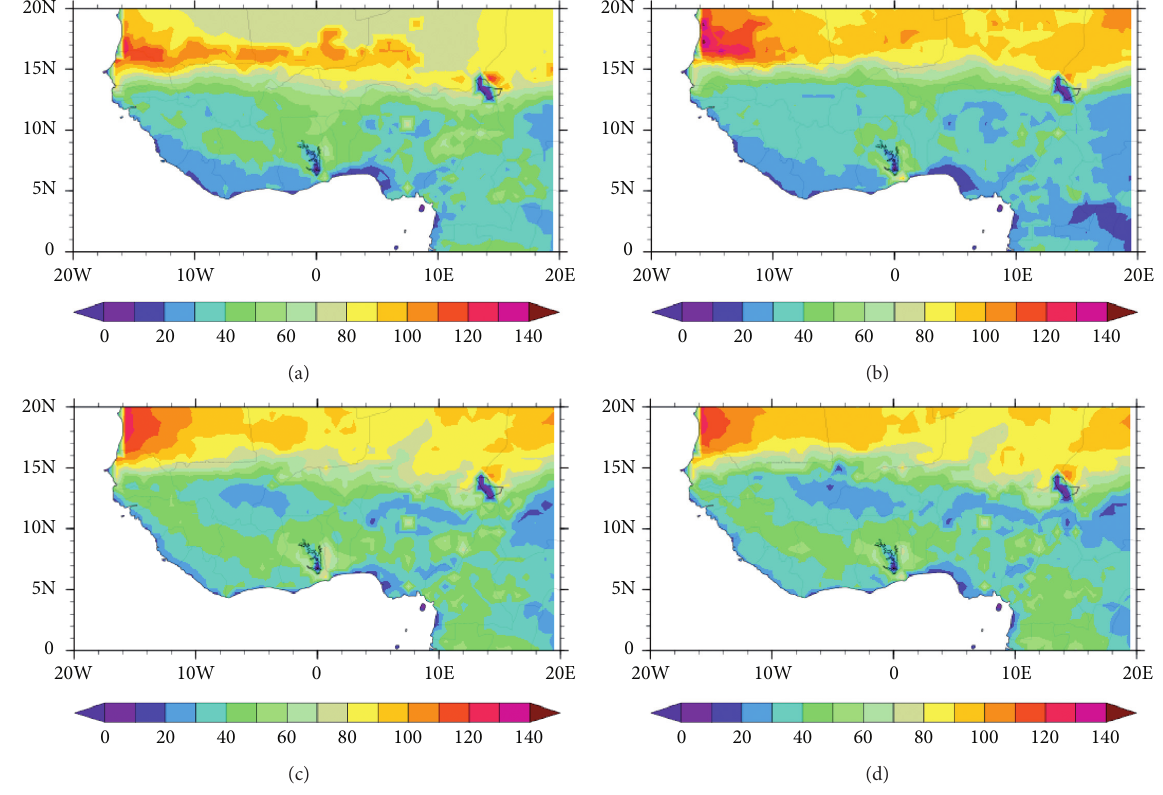
Figure 17: Spatial distribution of surface sensible heat (w/m 2 ) for July 16 th –Sept 29 th , 2012. (a) Naoh. (b) CLM4. (c) NaohMP. (d) NoahMP GW.